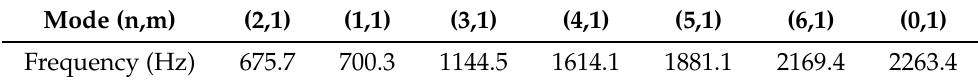
Table 5. Natural frequencies of the lowest radial mode orders of the assembly of the stator and